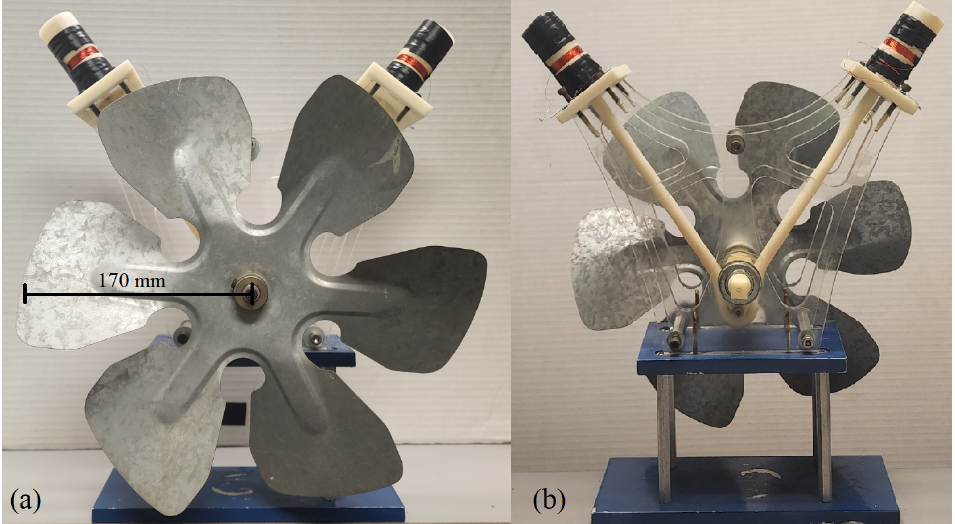
Figure 17. Front ( a ) and back ( b ) V-twin harvester